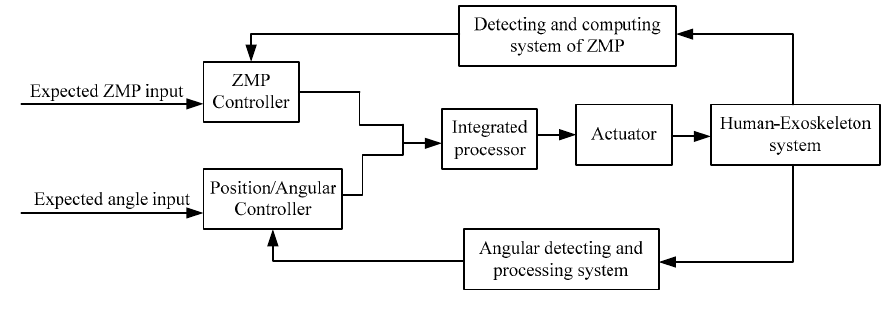
Figure 2. The overall control scheme.